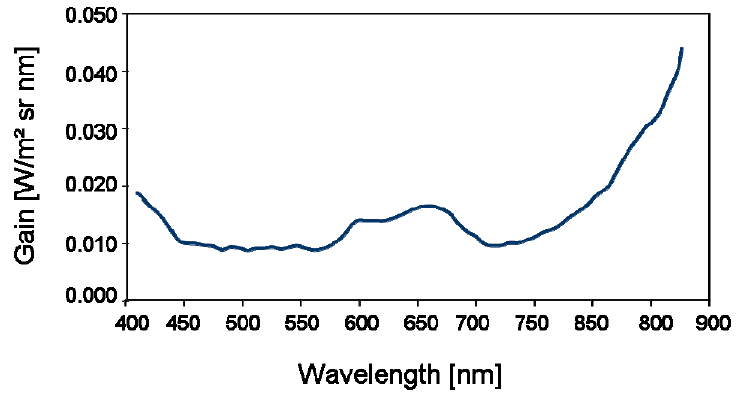
Figure 9. Spectral sensitivity calibration